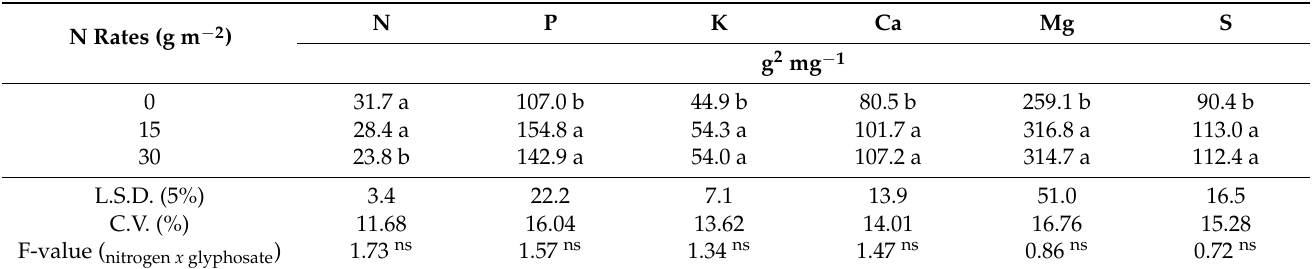
Table 3. Coefficient of the biological utilization of macronutrients by emerald grass as a function of nitrogen fertilization.